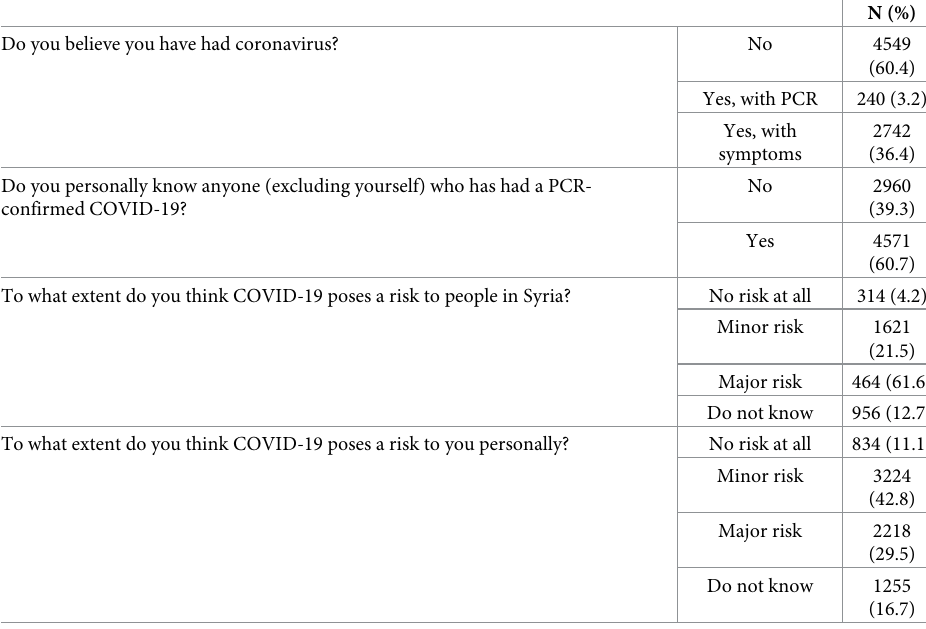
Table 2. COVID-19 related